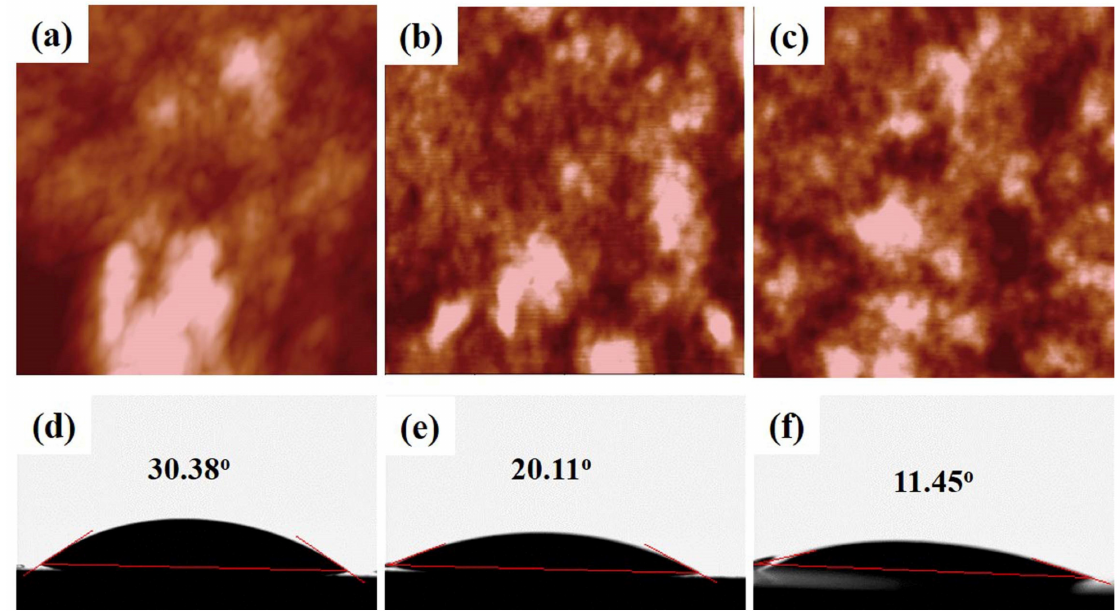
Figure 5. ( a – c ) Topography AFM images of ITO/(PEDOT:PSS + Au NR2)/(PTB7 + SnS 2 ) layer without and with ZnO layer; ( d – f ) Its video contact angle images.